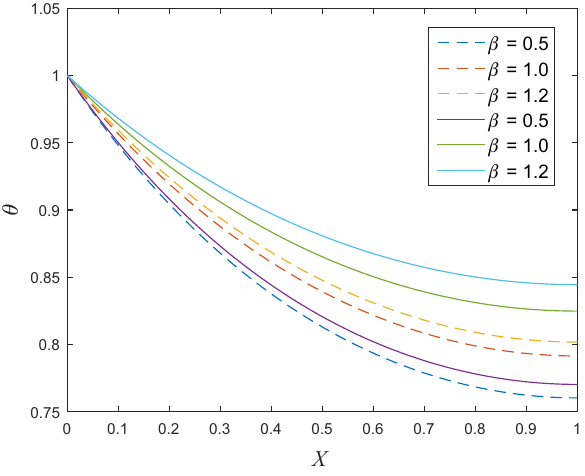
Figure 2: E ff ect of β (- - linear variation and — non - linear variation ) on the Temperature distribution of the fi